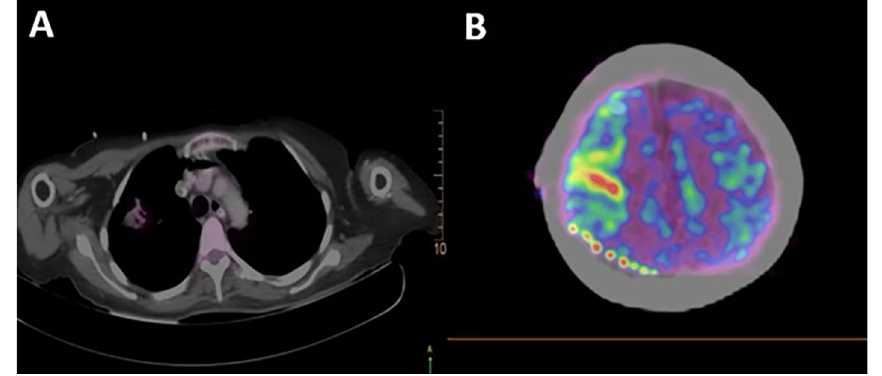
Figure 2. Total body 18F-fluorodeoxyglucose positron emission tomography (18F-FDG PET-CT): A. Pulmonary hypermetabolism without neoplastic mass in tomographic scanning (lung); B. FDG hypermetabolism at the right parietal region